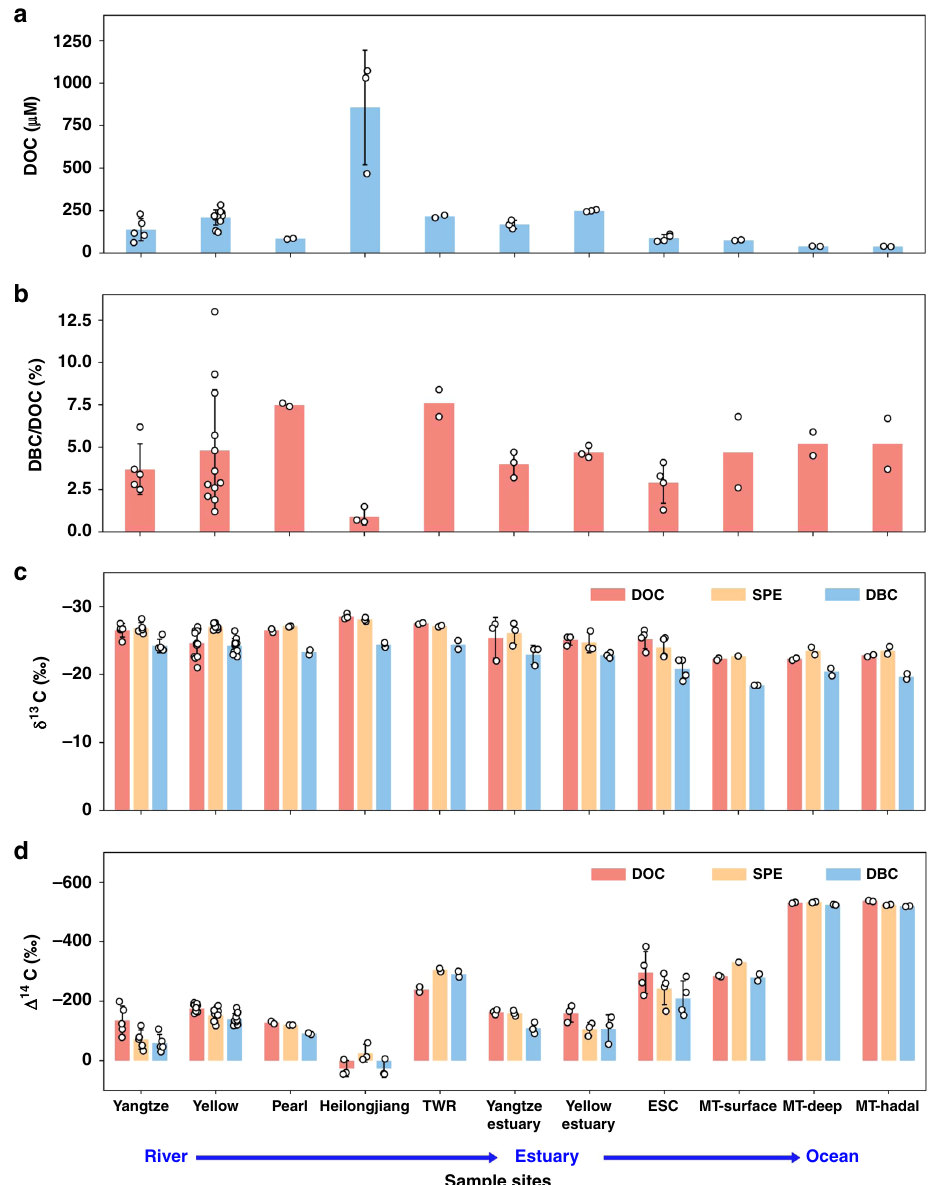
Fig. 1 Distribution of the concentrations and isotopic compositions. a The concentrations of DOC, b DBC/DOC ratios, c the δ 13 C values, and d the Δ 14 C values of DOC, SPE-DOC, and DBC in the Yangtze ( n = 5), Yellow ( n = 12), Heilongjiang ( n = 3), Pearl ( n = 2), and Taiwan rivers (TWR, n = 2), the Yangtze River Estuary ( n = 3), the Yellow River Estuary ( n = 3), the East China Sea (ECS) ( n = 4), and the Mariana Trench (MT) site in the North Paci fi c (NP) ( n = 2 MT-surface, n = 2 MT-deep, n = 2 MT-hadal) (DOC dissolved organic carbon, SPE-DOC solid phase extracted dissolved organic carbon, DBC dissolved black carbon). The bar charts are the means and the error bars are the calculated standard deviations (SD) of the data group (for n ≥ 3). The black circles are corresponding data Yellow River monthly DOC δ 13 C values also showed large var- Taiwan rivers (Fig. 1c). The δ 13 C values of SPE-DOC were − 26.1 ± 1.7 ‰ and − 24.7 ± 1.5 ‰ in the Yangtze River and Yellow iation, ranging from − 21.0 to − 27.0 ‰ . The DOC δ 13 C values were on average − 25.4 ± 3.0 ‰ in the Yangtze River Estuary, River estuaries, respectively, − 24.0 ± 1.5 ‰ in the ECS, and − 25.1 ± 0.8 ‰ in the Yellow River Estuary, − 25.2 ± 1.4 ‰ in the − 22.7 ‰ at the surface (50 – 100 m) and − 23.5 ± 0.8 ‰ in the deep ECS, and − 22.1 to − 23.1 ‰ at the Mariana Trench site in the NP. depths (3000 – 10,000 m) at the Mariana Trench site. These sam- In contrast, the δ 13 C values of SPE-DOC in each river were ples showed no signi fi cant differences when compared with bulk mainly comparable with the bulk DOC δ 13 C values for most DOC δ 13 C values. The δ 13 C values of DBC ranged from − 22.6 ‰ samples and were also quite constant in each river, especially for to − 26.4 ‰ in the rivers and − 21.3 to − 23.7 ‰ in the estuaries, − 20.8 ± 1.6 ‰ in the ECS and − 18.4 ‰ to − 20.9 ‰ in the the Yellow River monthly samples. The average δ 13 C values of SPE-DOC were − 26.8 ± 0.8 ‰ in the Yangtze River, − 27.8 ± Mariana Trench site, which are considerably higher than the δ 13 C values of both DOC and SPE-DOC in the rivers and oceans. As 0.4 ‰ in the Yellow River, − 27.0 ± 0.1 ‰ in the Pearl River, − 28.1 ± 0.3 ‰ in the Heilongjiang River, and − 27.1 ± 0.1 ‰ in the plotted in Fig. 1c, the average DBC δ 13 C value was enriched by